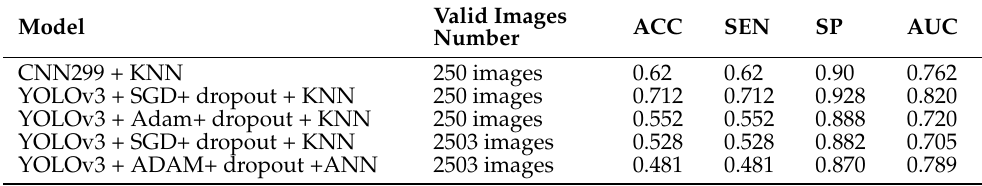
Table 16. The results of DR stages classification using Lesion localization Method on the DDR